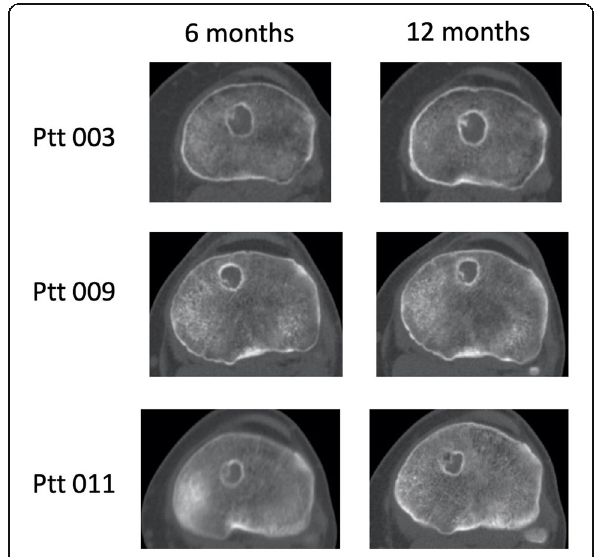
Fig. 2 CT scanning images of characteristic bone ingrowth pattern. Three examples of average ingrowth at 6 and 12 months follow-up are